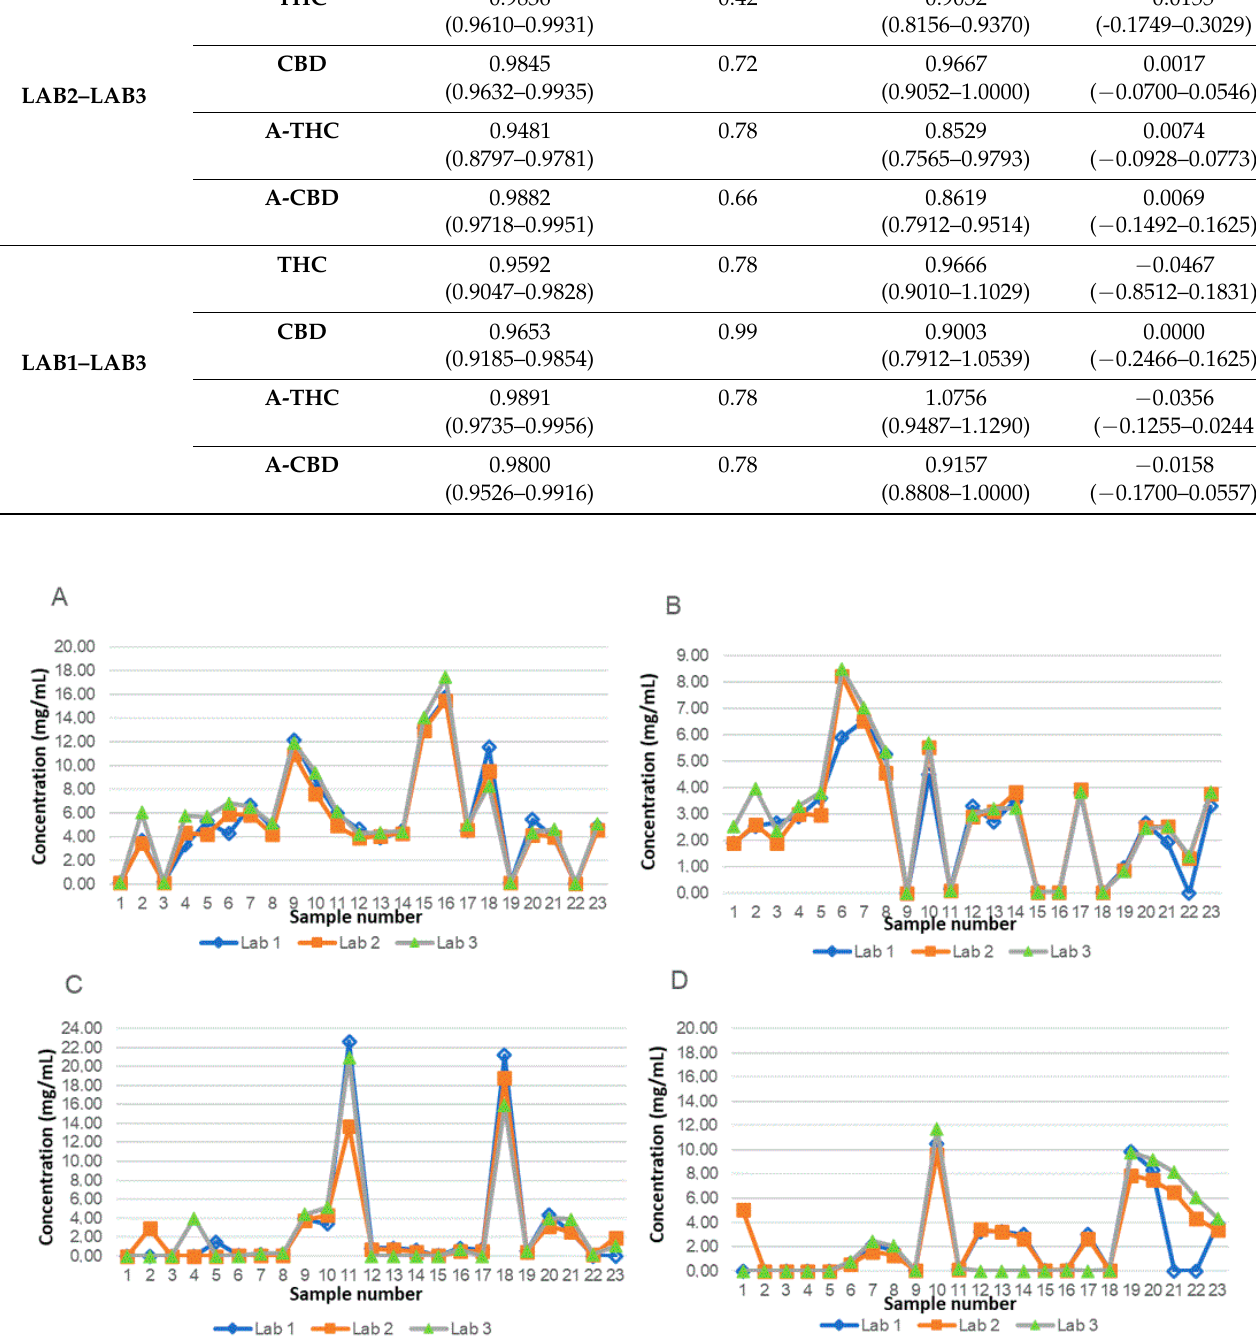
Figure 2. Concentration (mg/mL) of THC (panel A ), CBD (panel B ), THC-A (panel C ) and CBD-A (panel D ) measured on 23 galenic preparations in the three laboratories during cross-validation.